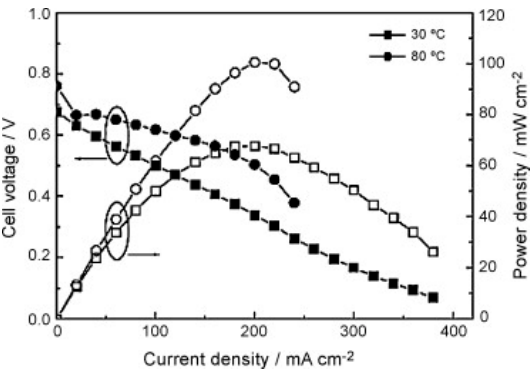
Figure 9. Polarization curves of a H 2 /O 2 fuel cell using a SPI-1.51(50) composite membrane without humidification at gas utilization ratios of 30% for H 2 and 15% for O 2 ( ■ , □ ) operation at 30 °C, ( ● , ○ ) operation at 80°C; reproduced with permission from [208].